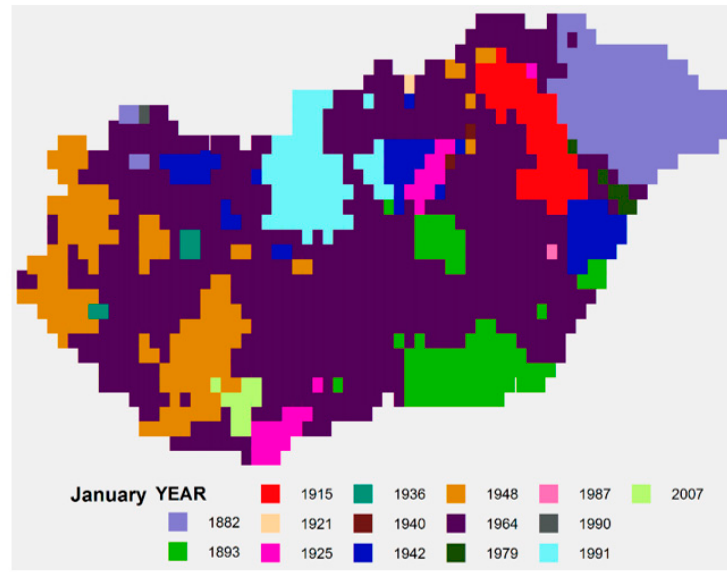
Figure 4. January: Year of maximum SPTI values, 1871–2020.